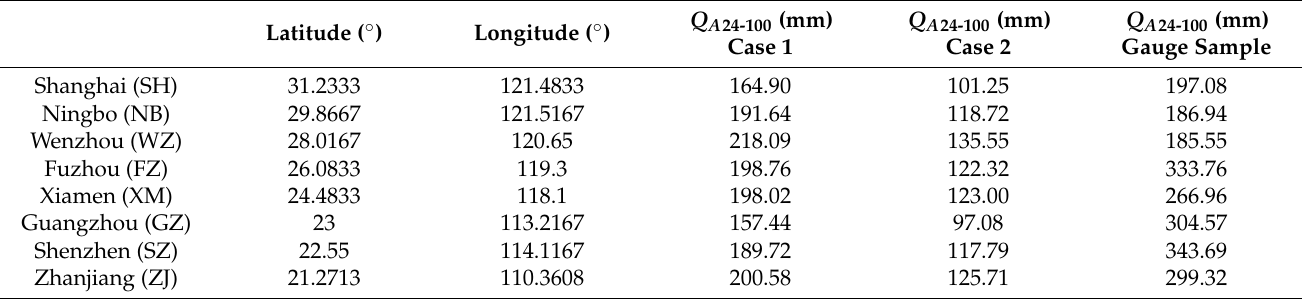
Table 4. Comparison of the estimated accumulated rain